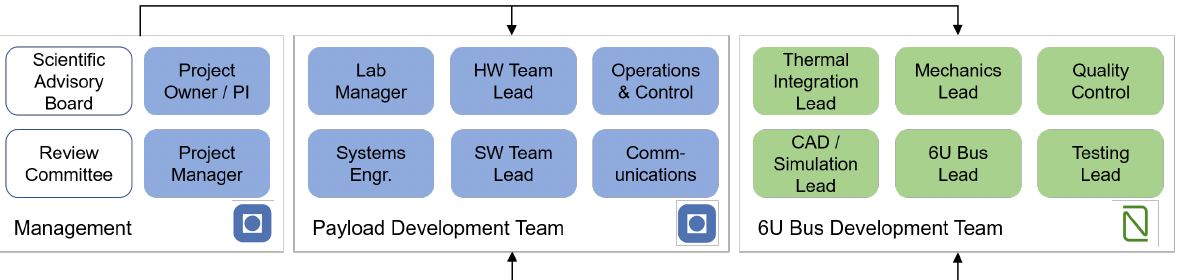
Figure 3. The overall organization of AIT responsibility for HYPSO-1. The NTNU team is shown in blue, NanoAvionics in green, and external participants in